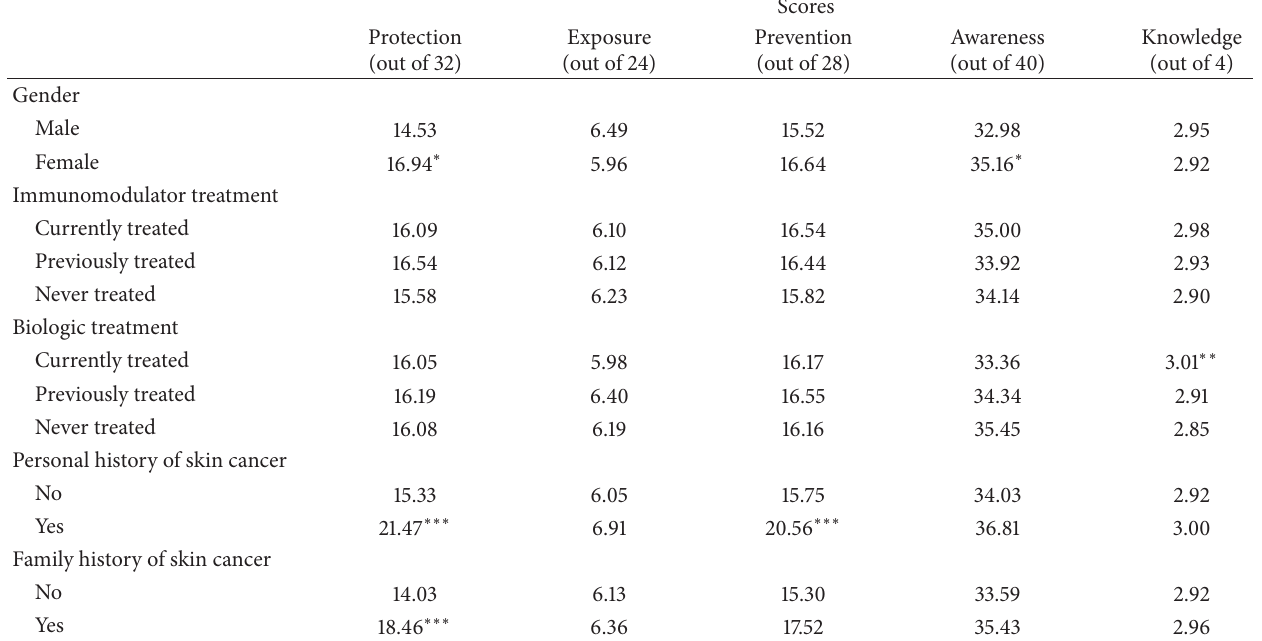
Table 4: Mean differences for skin cancer variables by various demographics and treatment.